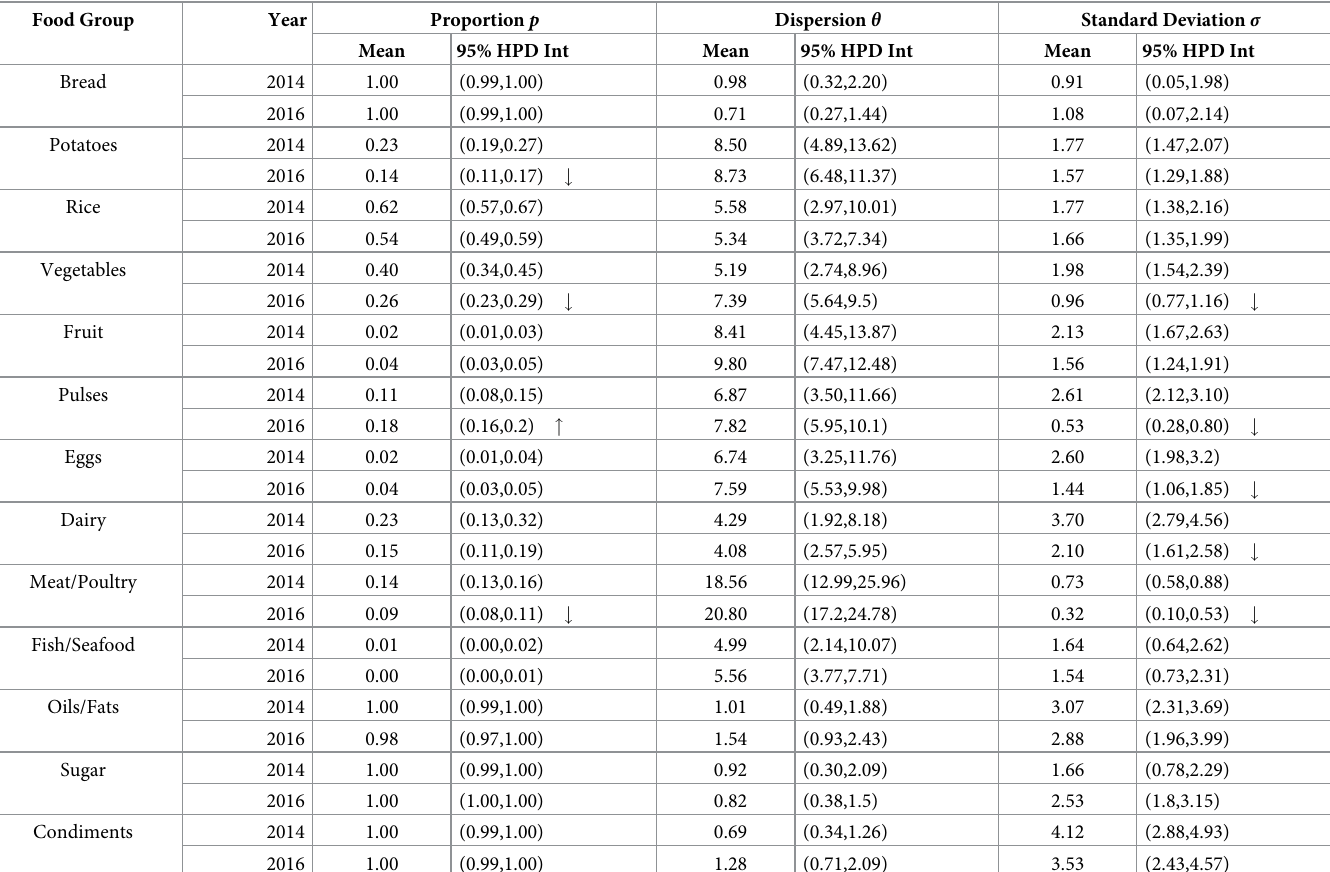
Table 1. Parameter estimates for 2014 and 2016 models in